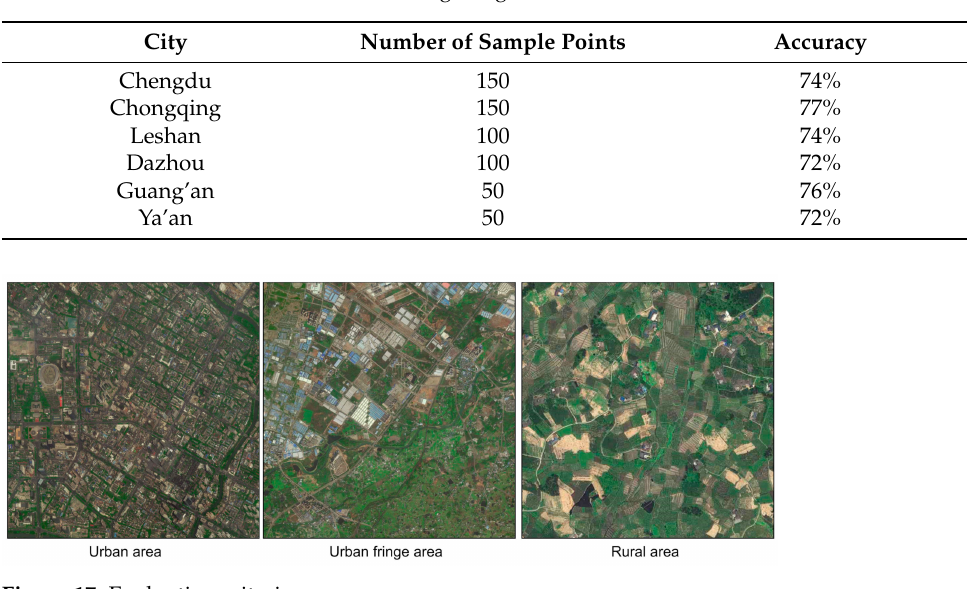
Figure 17. Evaluation